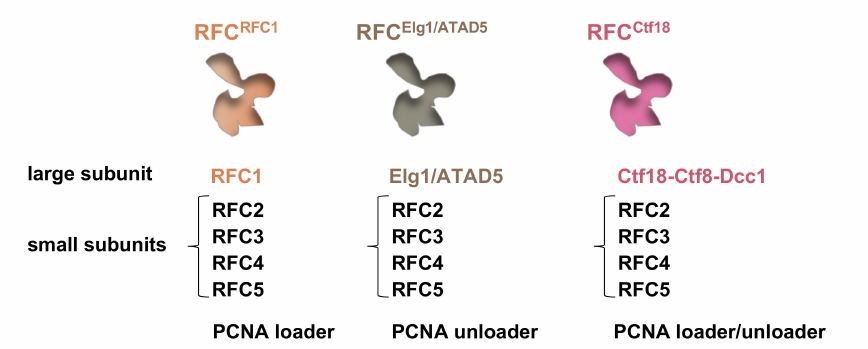
Figure 2. Replication factor C and its alternative forms involved in chromosomal cohesion. Subunit composition and role of each factor are reported. RFC Ctf18 contains Ctf8 and Dcc1 as two additional